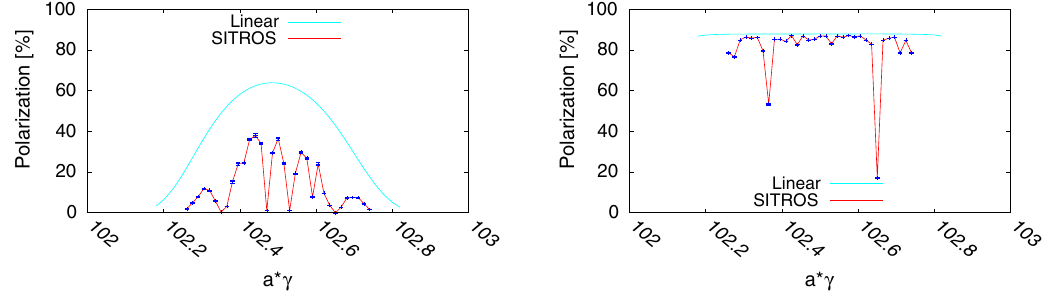
¼ 200 μ m and 10% y